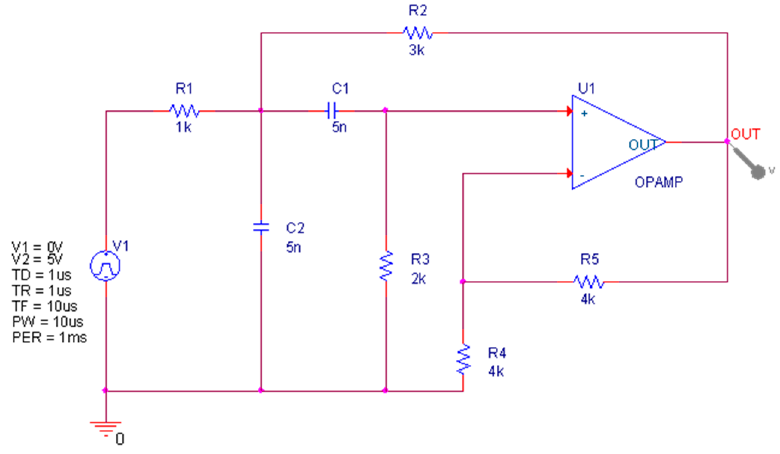
Figure 3. Shalley–Key Bandpass Filter model.